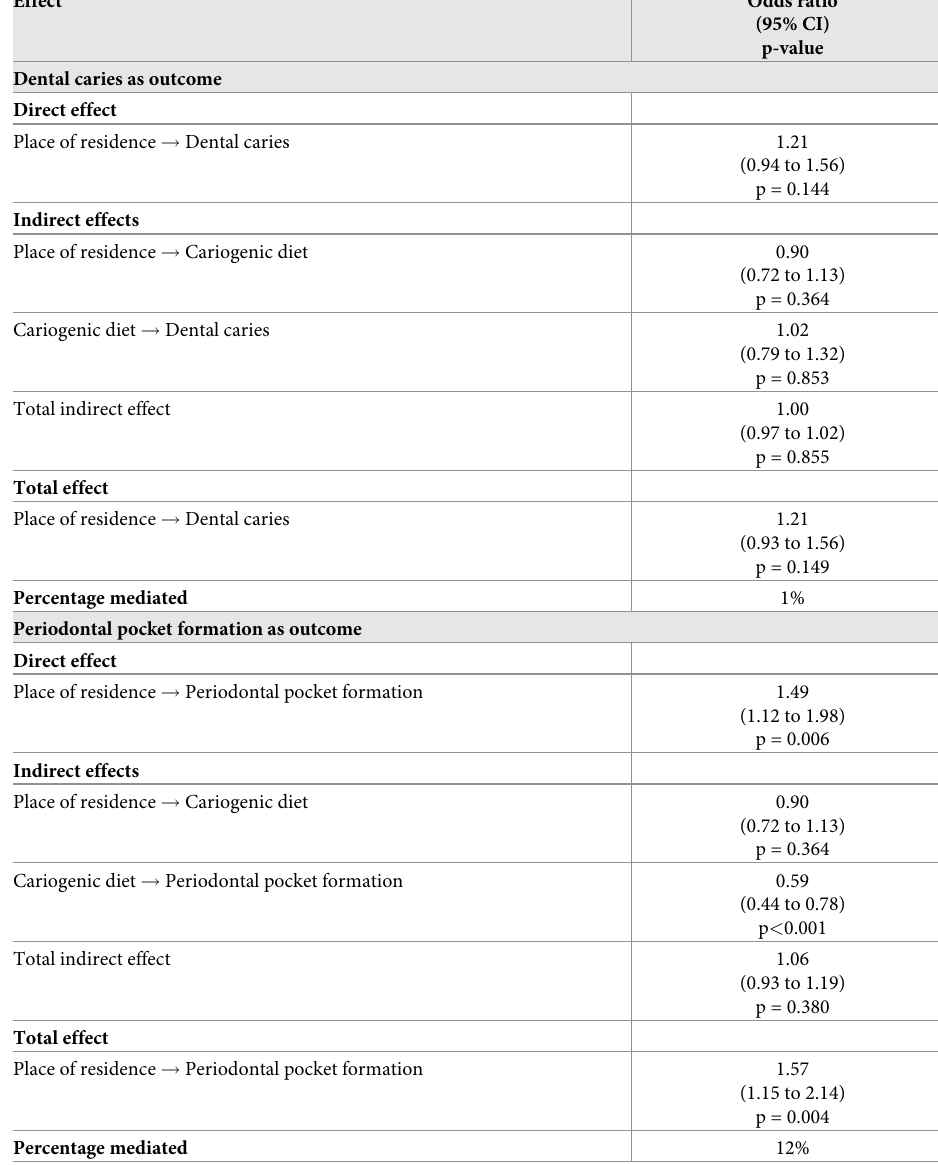
Table 4. Generalized structural equation modeling to explore potential mediator cariogenic diet on the relation- ship between place of residence and dental